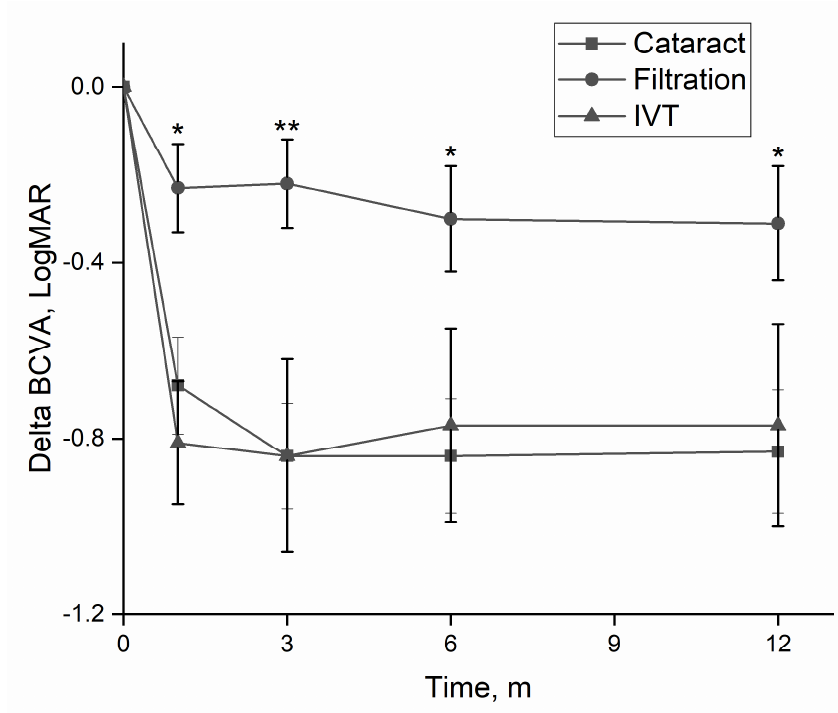
Figure 3. Change in visual acuity according to etiology. Eyes with endophthalmitis following filtration surgery had significantly less improvement in visual acuity, than eyes following cataract surgery or intravitreal injections. BCVA—best-corrected visual acuity, m—months. *— p < 0.05; **— p < 0.01 (one-way ANOVA). Table 2. Factors related to vision Table 1. Clinical findings and visual outcome among eyes with endophthalmitis related to post- cataract surgery, post-filtration surgery, and post intravitreal injections.